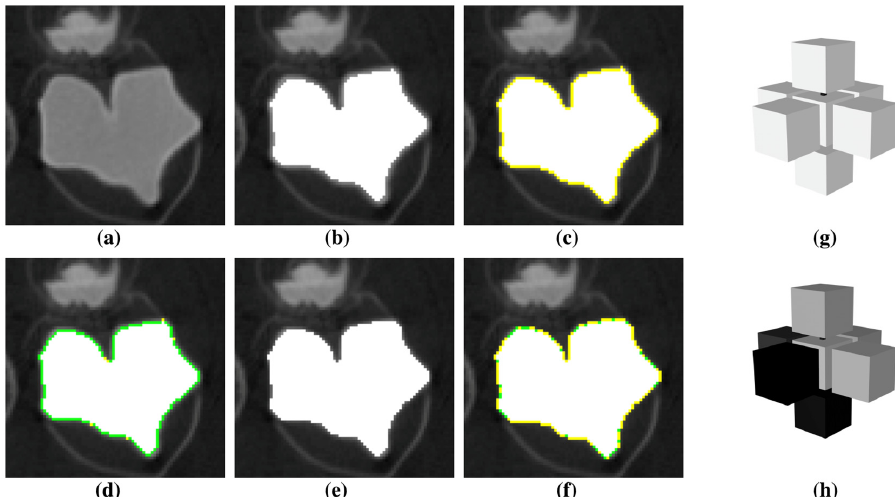
Figure 12. The 3D region growing method to recover lost voxels. ( a ) The raw CT image; ( b ) Detected grain region by erosion processing; ( c ) The yellow voxels are candidate voxels by the first iteration; ( d ) The green voxels are newly grown grains; ( e ) The newly grown voxels are set to seeds; ( f ) Candidate voxels (in yellow) and newly grown grain voxels (in green) by the second growing iteration; ( g ) Six-neighboring voxels in 3D view; ( h ) An example of an voxel on grain surface and its six-neighboring voxels.